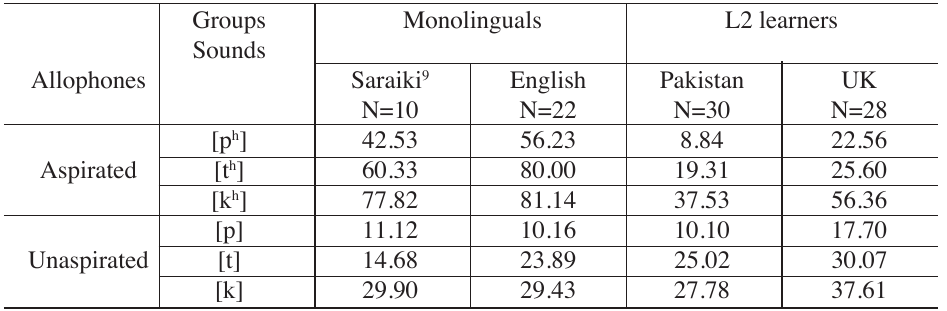
Table 2: Mean VOT